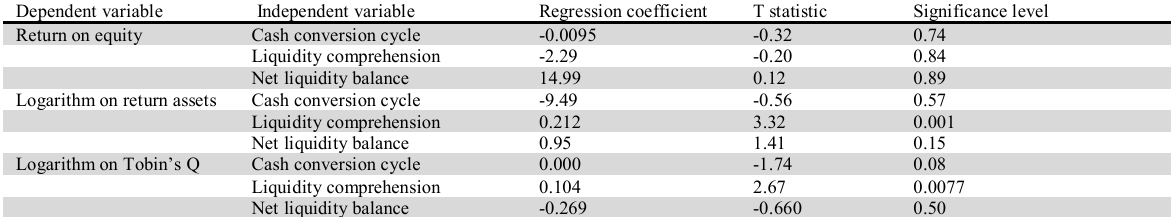
The results testing the relationship between ROA Ln ROA and Tobin’s Q Dependent variable Independent